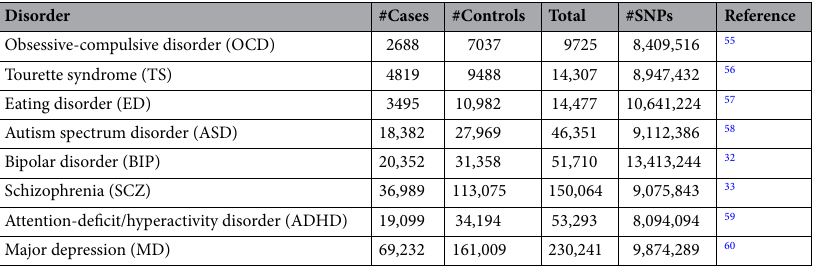
Table 13. Information on summary statistics for the eight psychiatric disorders used in the experiments. Note that we used summary statistics only for samples of European ancestry. For MD, we used the summary statistics generated by UK biobank, excluding the 23andMe samples; for BIP, we used the summary statistics including all three patient